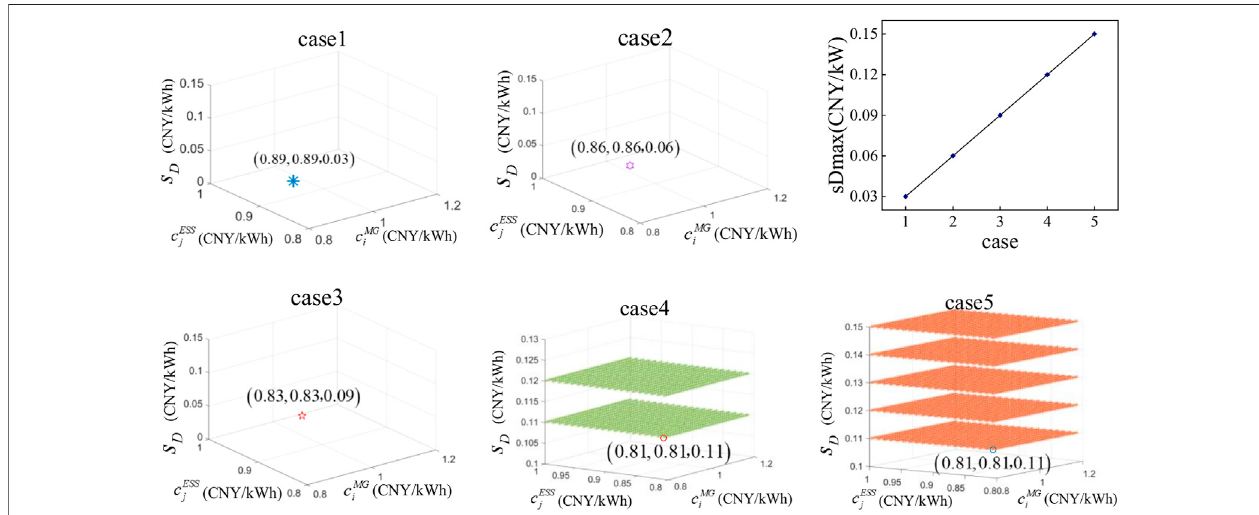
FIGURE 8 | Three-dimensional distribution of the NE solutions as s D max increases.